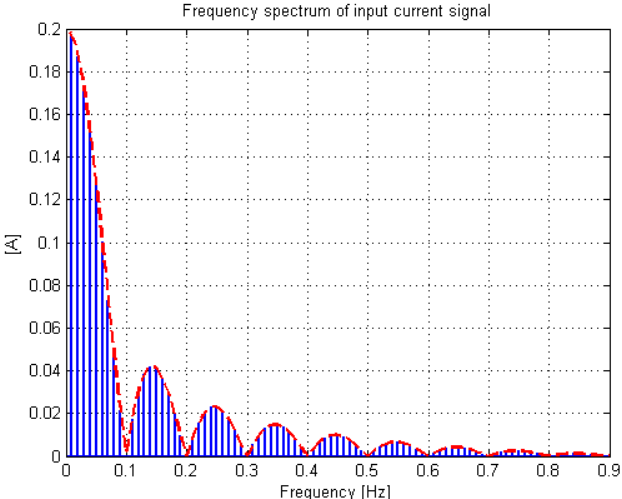
Figure 7. Discrete spectrum of trapezoidal pulse of T 1 = 10 s, T 2 = 1 s and acquisition duration T c = 100 s ( f min = 0.01 Hz).